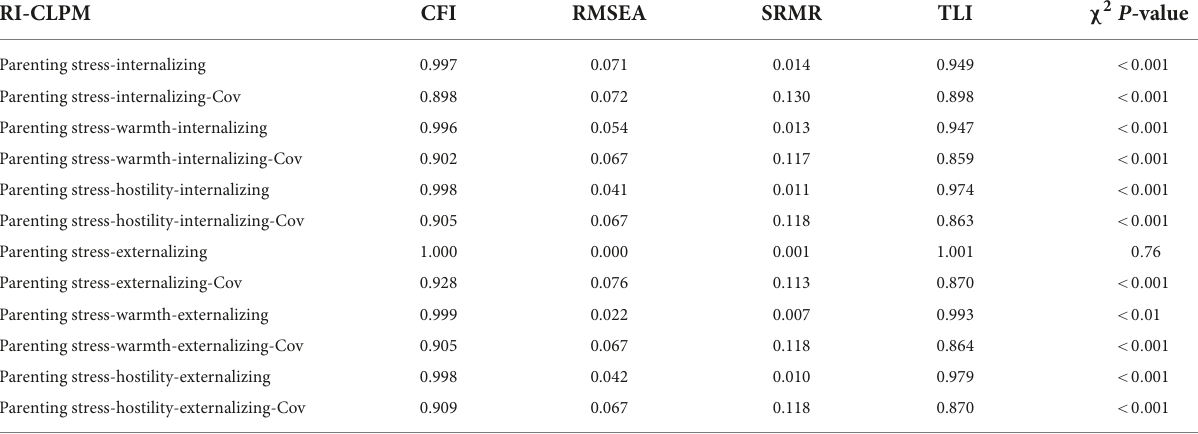
TABLE 4 Model fit for all random-intercept cross lagged models with and without covariates included.